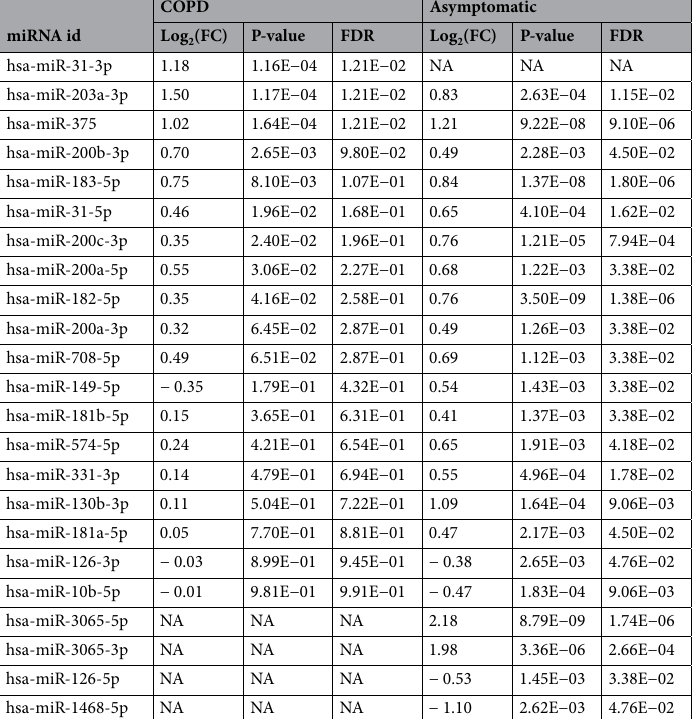
Table 2. Differential expression of miRNAs for respiratory healthy controls and subjects with COPD when comparing smoking status. FC fold change, FDR false discovery rate (Benjamini Hochberg corrected p-value). Differentially expressed miRNAs with an FDR < 0.05 are shown. The table is sorted by the P-value of the COPD participants. NA’s are given for probes not available in the